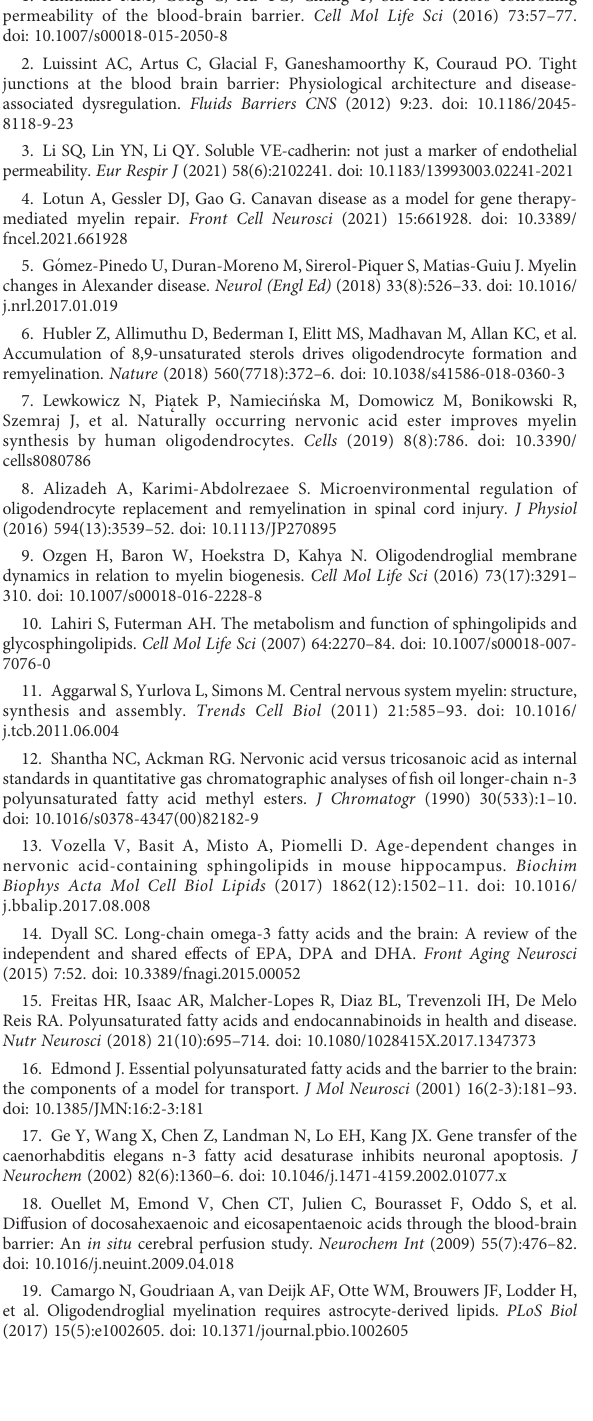
products. Data are presented as the percentage of lipids from three independent experiments. SUPPLEMENTARY TABLE 2 The lipid species identi fi ed in FOM and BO using RP-LC-Q-Orbitrap HRMS analysis. Data are presented as the percentage of lipids from two independent